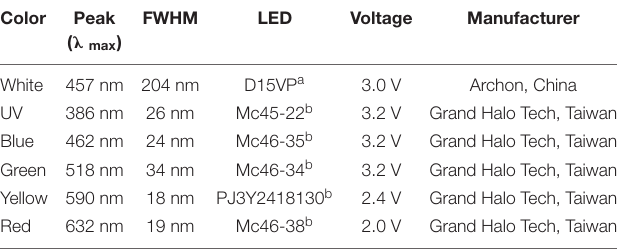
the maximum response amplitude ( Supplementary Data 2